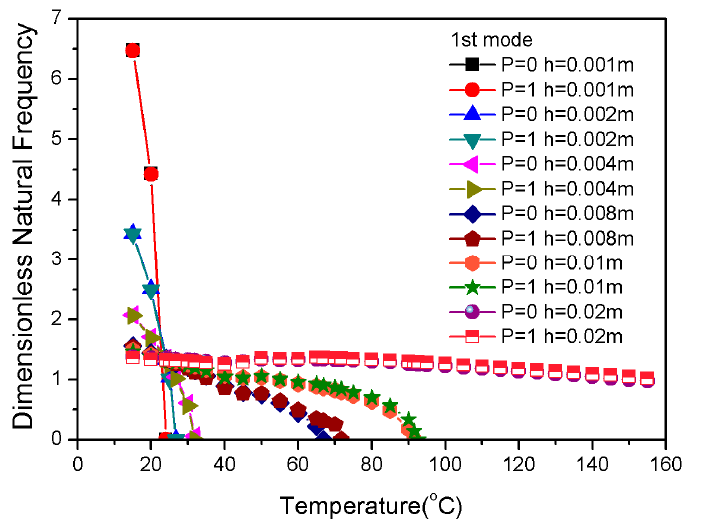
Figure 14. Dimensionless natural frequencies vs. temperature with varying thicknesses.